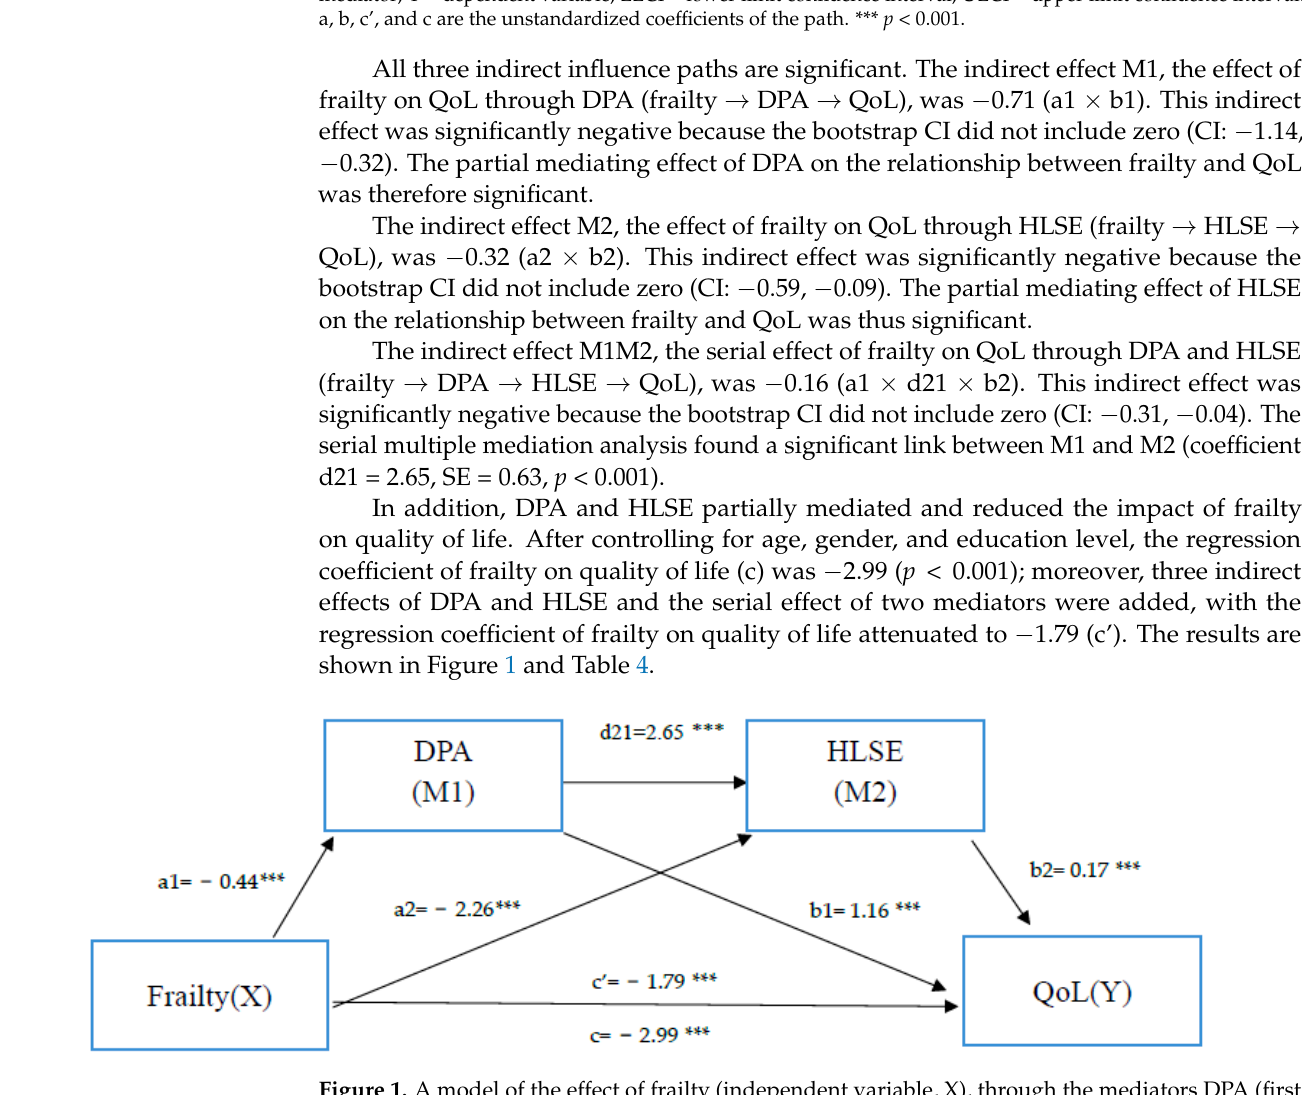
Table 4. Bootstrapping indirect effects and 95% confidence intervals (CI) for the final mediation model.